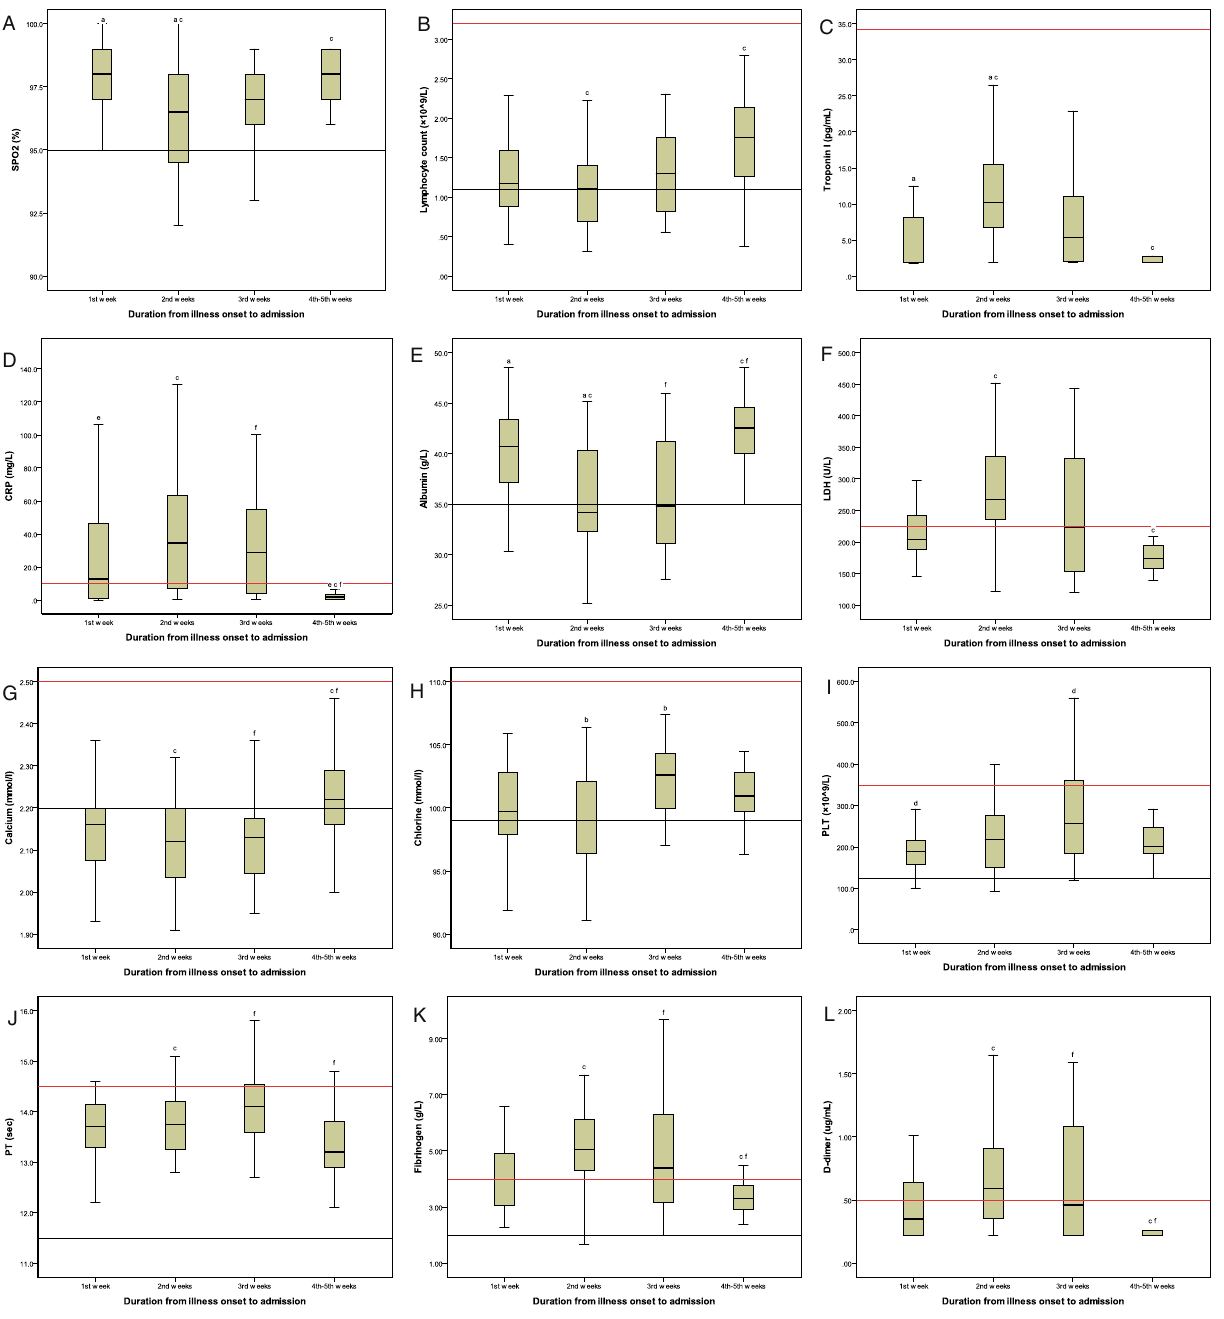
Figure 1. Dynamic profiles of clinical signs over time in non-severe patients with COVID-19. In the first week after symptoms onset, COVID-19 patients showed remarkably decreased levels of lymphocyte count and calcium and slightly increased levels of C-reactive protein, lactic dehydrogenase, fibrinogen, and D-dimer. Meanwhile, the levels of albumin, high sensitive troponin I, and pulse oximeter O 2 saturation remained unchanged. All the clinical signs, including lymphocyte count, electrolyte, albumin, high sensitive troponin I, C-reactive protein, lactic dehydrogenase, fibrinogen, D-dimer, and pulse oximeter O 2 saturation, were at the peak (bottom) in the second week after symptoms onset. The majority of clinical signs improved in the third week, whereas C-reactive protein, lactic dehydrogenase, fibrinogen, and D-dimer were still at a relatively high level. All the above indicators were maintained at a significantly low (high) level during the fourth week to the fifth week after symptoms onset. Upper limit of reference interval (red line); Lower limit of reference interval (black line). SPO 2 pulse oximeter O 2 saturation, PLT platelet count, CRP C-reactive protein, LDH lactic dehydrogenase, PT prothrombin